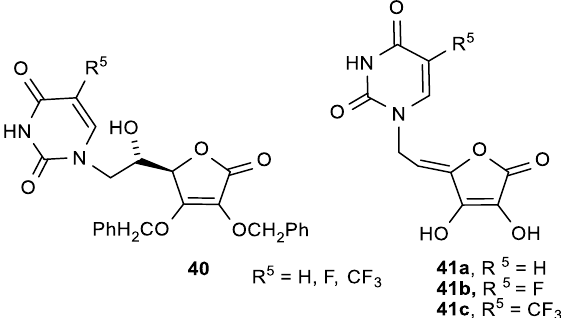
Figure 18. Pyrimidine derivatives of 2,3-di- O -benzyl-6-deoxy- L -ASA ( 40 ) and 4,5-didehydro-5,6-dideoxy- L -ASA ( 41 ). Table 15. The antiproliferative effect of the pyrimidine 4,5-didehydro-5,6-dideoxy- L -ASA derivative. IC 50 (μg/mL)